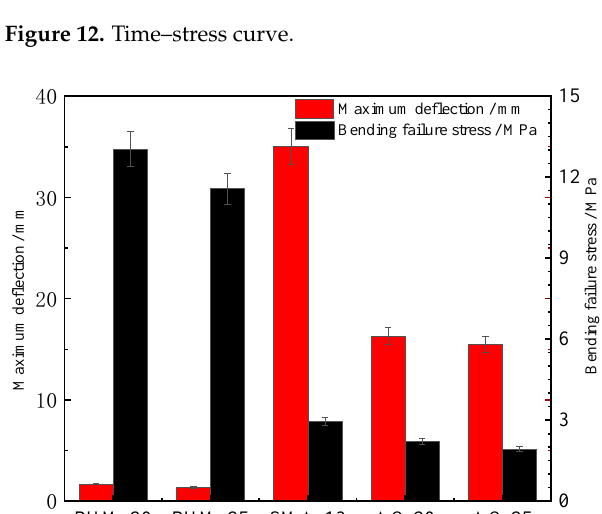
Figure 13. Maximum deformation and damage loads.